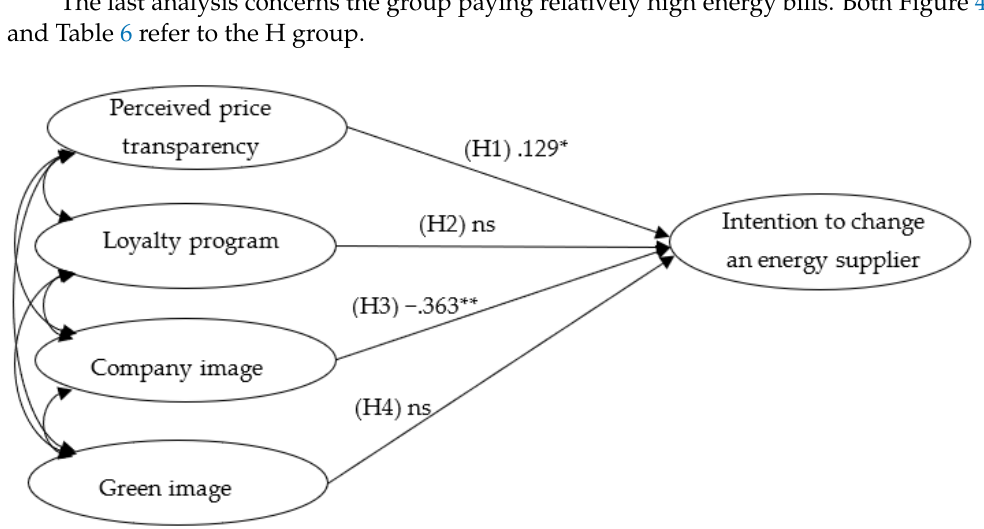
Figure 4. Summary of the research results (H group). Note: ** p < .001; * p < .05, ns — nonsignificant. Table 6. Verification of research hypotheses (H group).